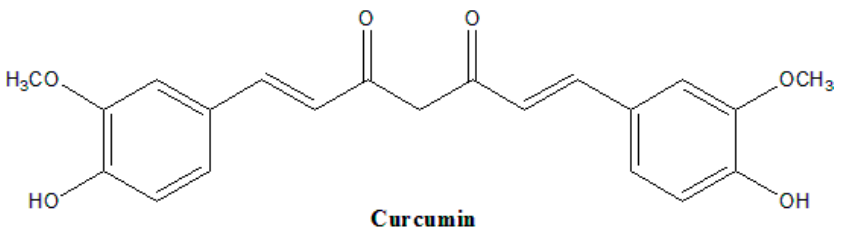
Figure 1. Molecular structure of curcumin.